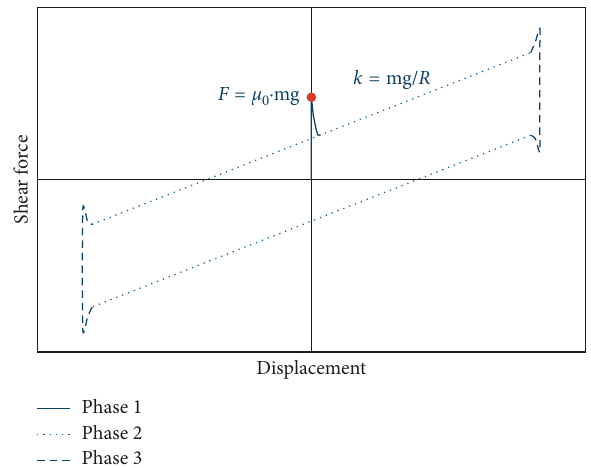
Figure 4: Effective force-displacement diagram of a CSS. The three different phases with different friction factors are